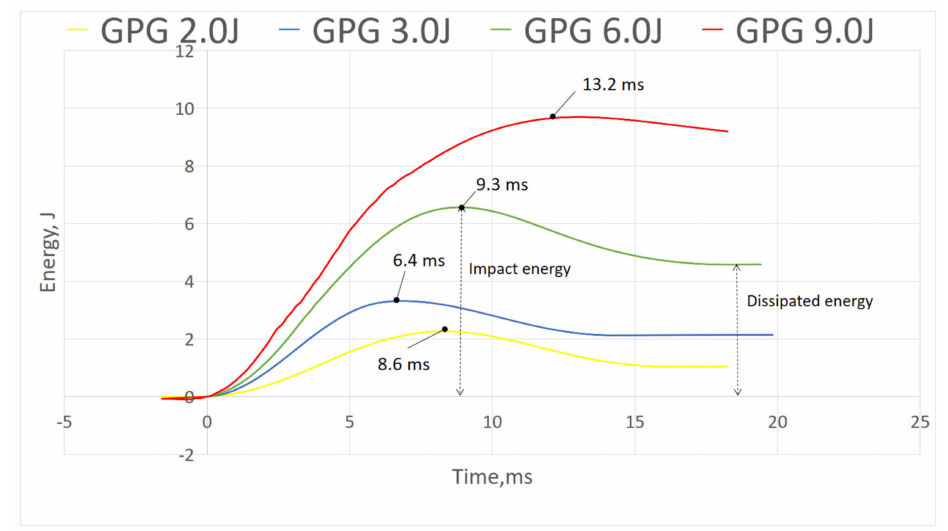
Figure 13. Energy-time of